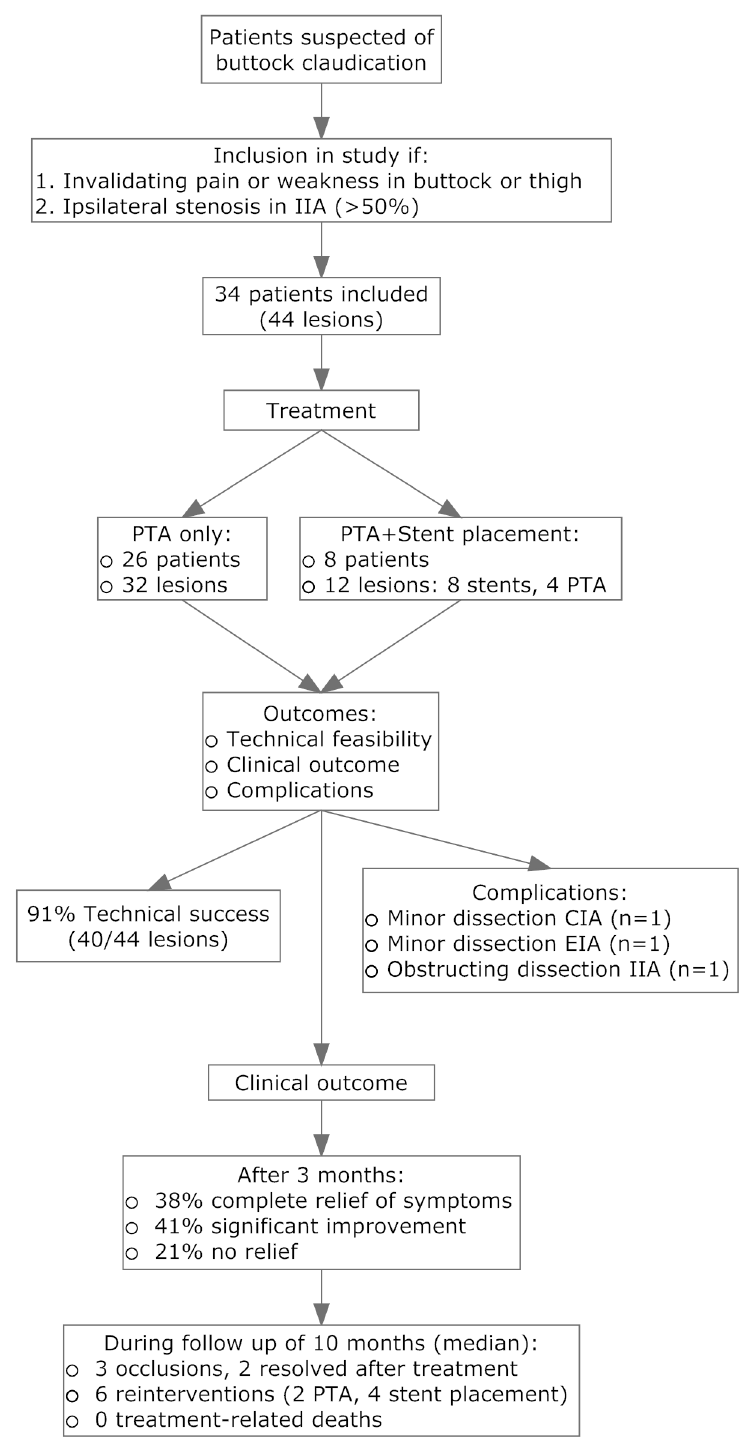
Figure 1. Flowchart of study design. IIA = Internal Iliac Artery. CIA = Common Iliac Artery. EIA = External Iliac Artery.